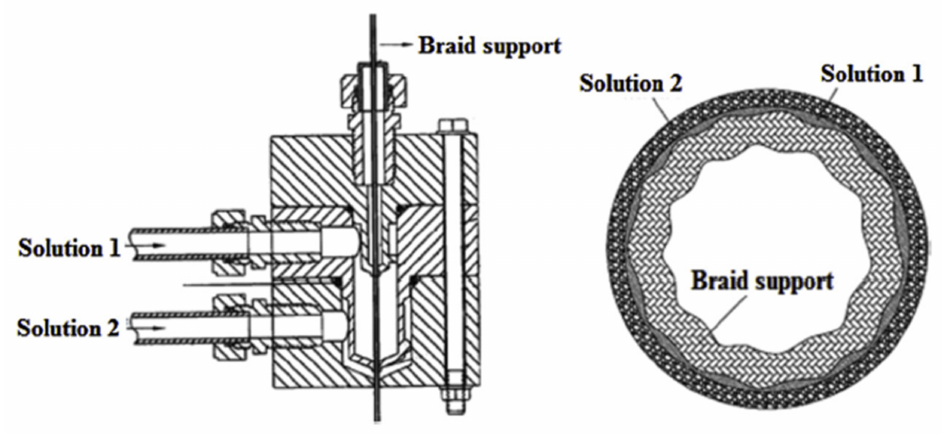
Figure 22. Nozzle having at least 2 different inlets [222]. Adapted from [222].